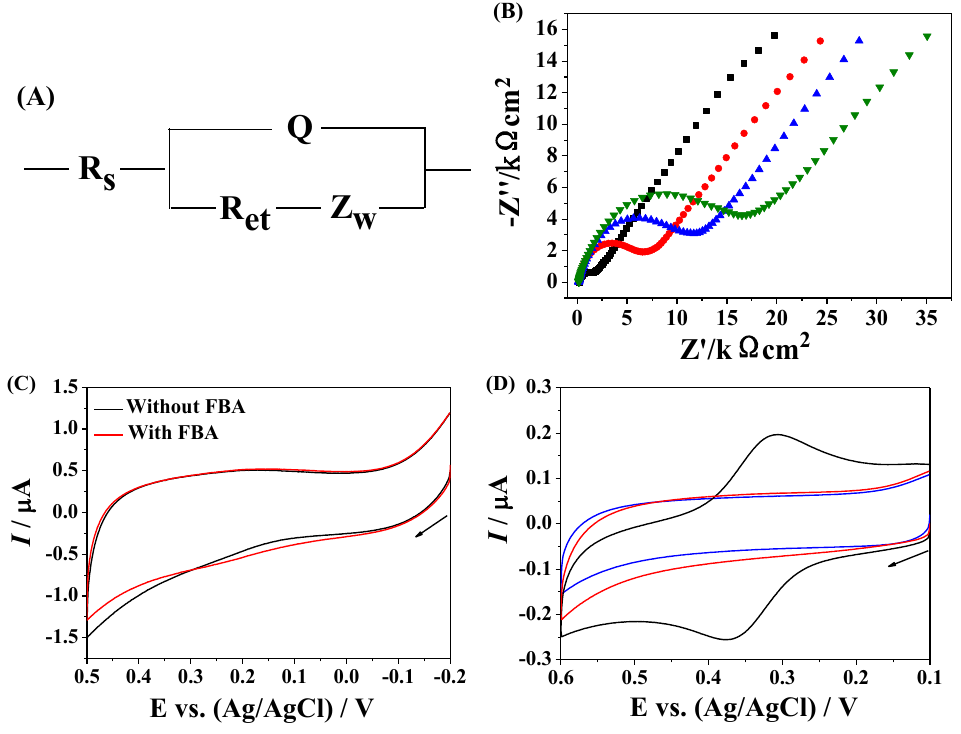
Figure 4. ( A ) The fits with the Randles equivalent circuit; ( B ) electrochemical impedance spectroscopy (EIS) of bare (black curve), biotin-covered (red curve), biotin/MCH/ BSA-covered (blue curve), and biotin/MCH/BSA/avidin-covered (olive curve) gold electrode; ( C ) CVs of the biotin/MCH/BSA/avidin-covered electrode before (black curve) and after (red curve) incubation with FBA solution; ( D ) CVs of the biotin/MCH/BSA-covered electrode with (black curve) and without (red curve) the capture of avidin, followed by the attachment of Fc–MBA–AuNPs. The blue curve in panel D corresponds to that with streptavidin in place of avidin. The concentration of avidin was 157 pM, and the arrow indicates the scan